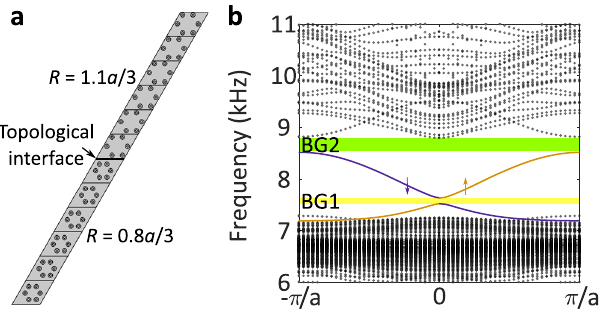
Fig. 2 Supercell and its dispersion relation. a A supercell made by placing six non-trivial ( R = 1.1 a /3) and six trivial ( R = 0.8 a /3) cells adjacently. b Eigenfrequencies of the supercell as a function of wave numbers in the periodic direction. Bulk bands are in black. There are two edge modes with opposite pseudospins (purple and yellow) inside the bulk band gap, where two mini gaps (BG1 and BG2) are generated.